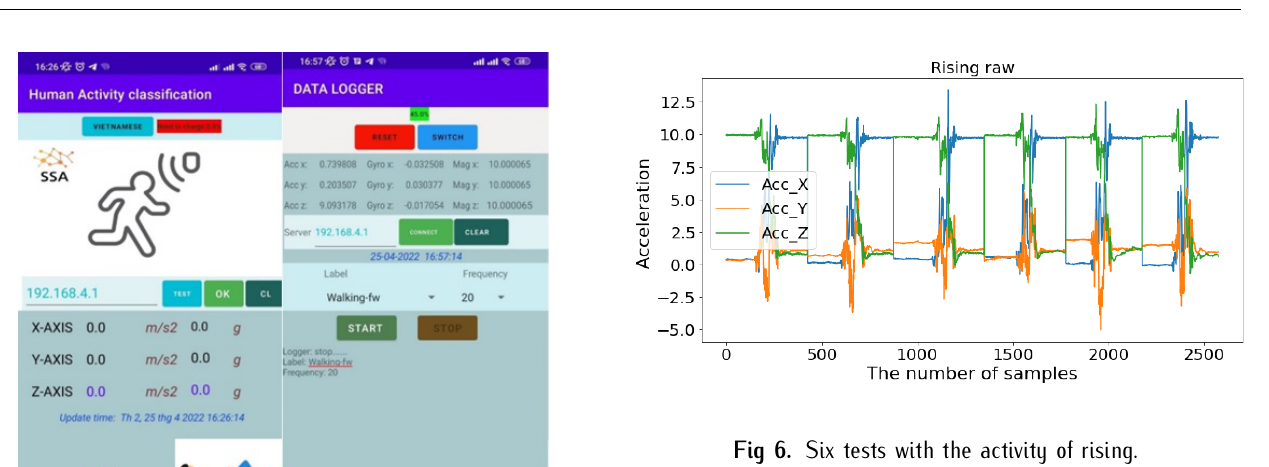
Fig 5. Low battery warning on the app (left) and data logger application interface (right).